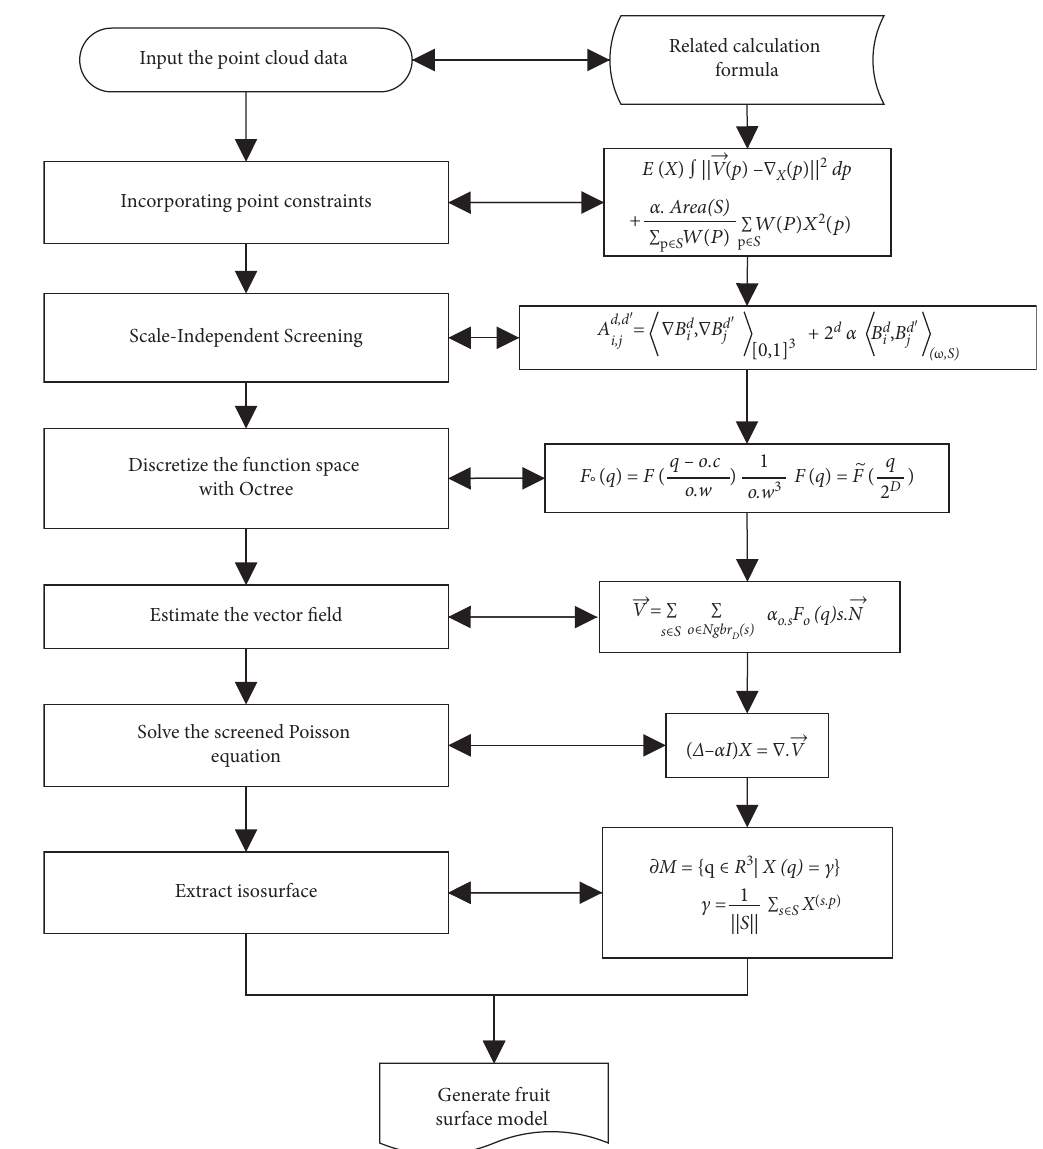
Figure 6: Flowchart of the screened Poisson reconstruction